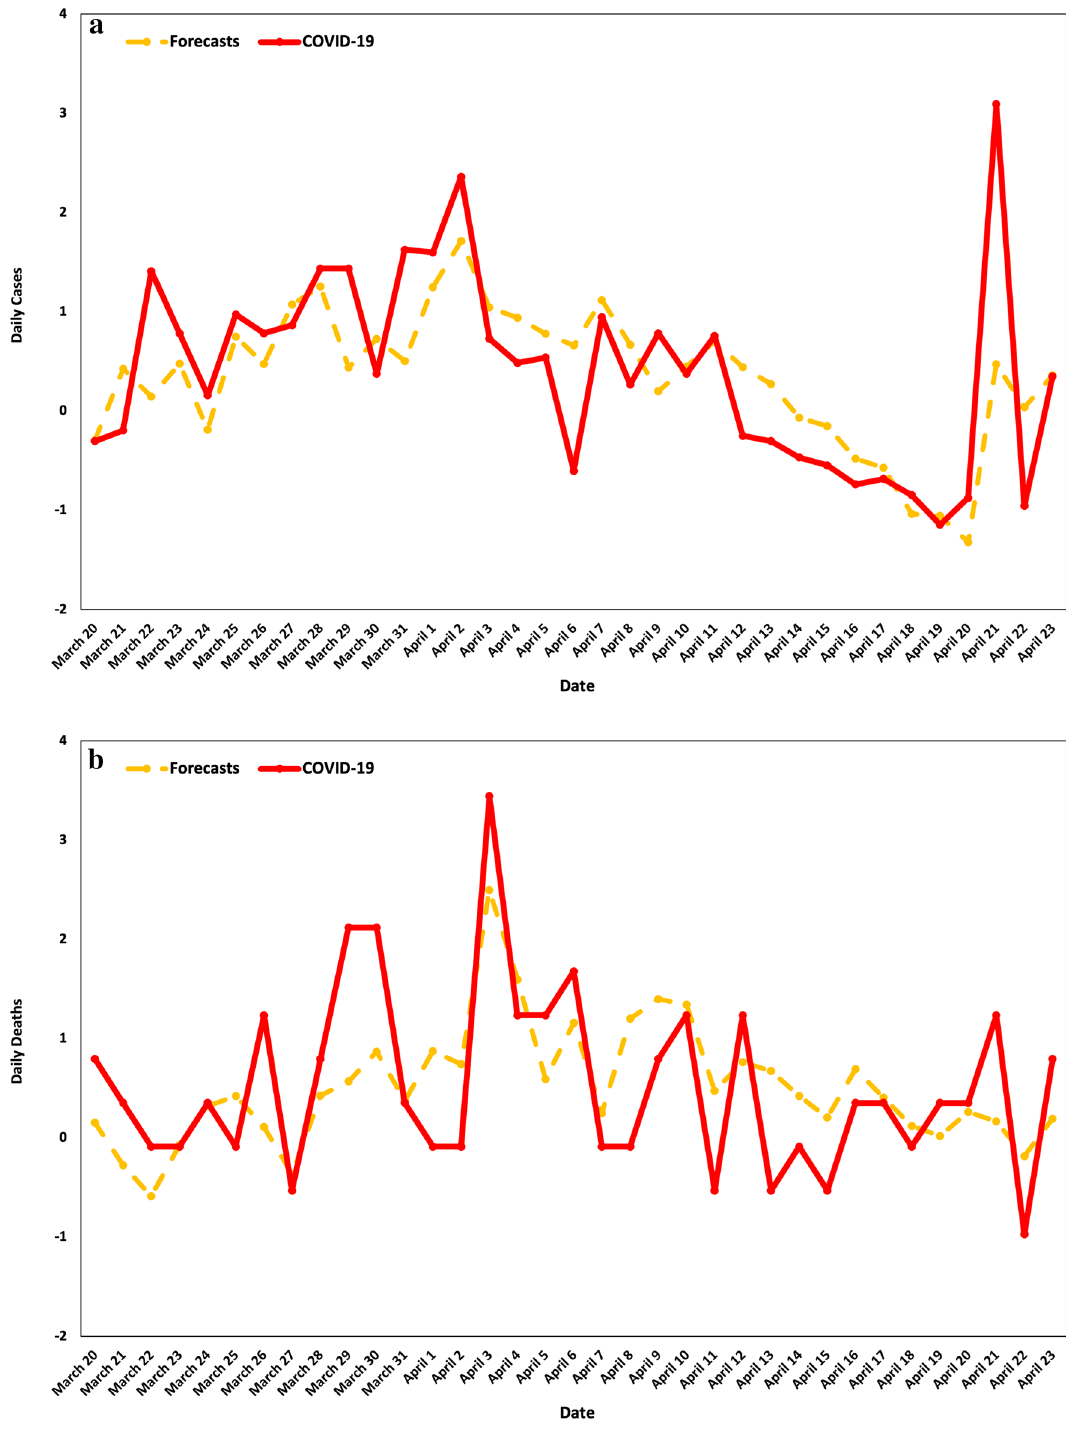
Figure 6. Official COVID-19 data on ( a ) daily cases vs. forecasts and ( b ) daily deaths vs.